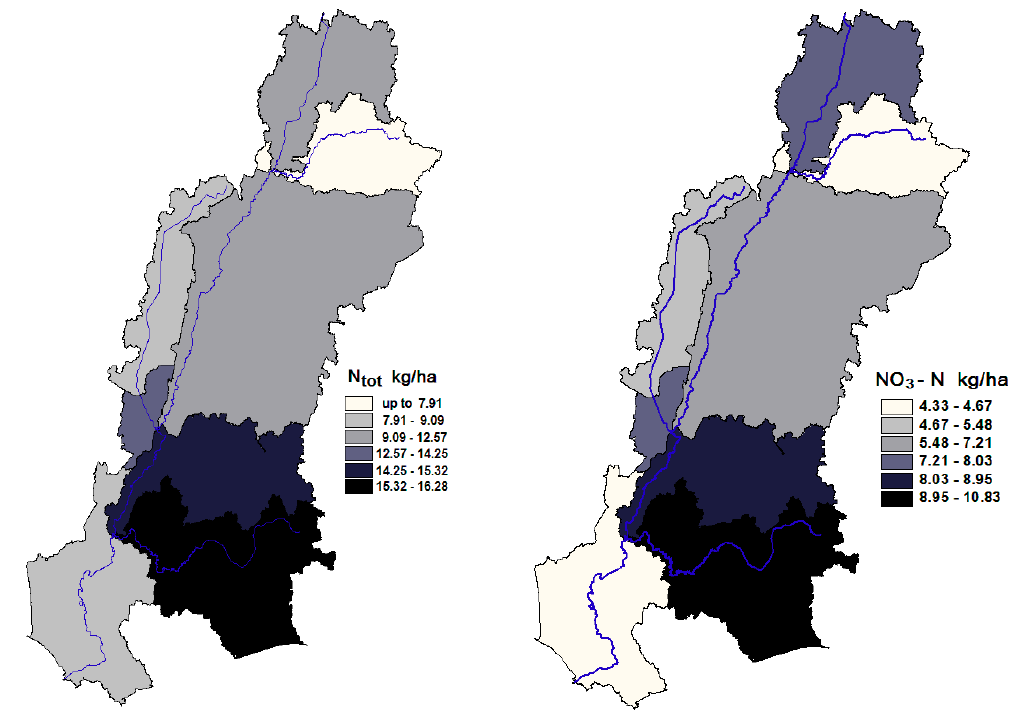
Figure 5. Average annual N-tot loss from each the Akmena-Dan ė River sub-catchment with corresponding loss of NO 3 -N via tile drainage systems (SWAT model simulations).